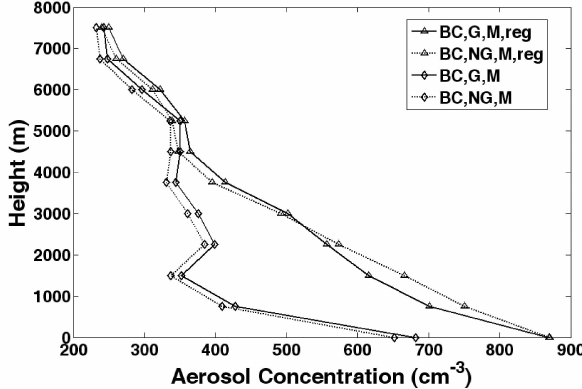
Fig. 12. Average vertical distribution of aerosol concentrations (in cm-3) for the entire simulation time (06:00–12:00UT) in the area which is marked by a red rectangle in Fig.